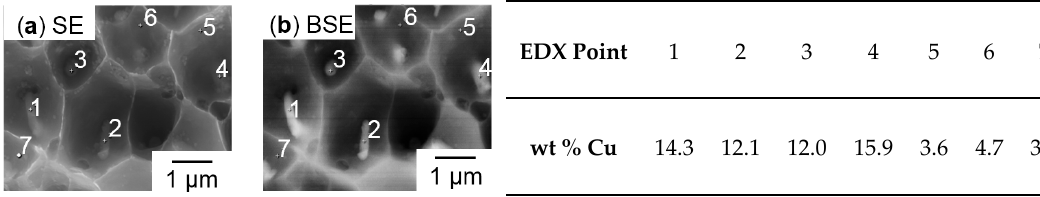
Figure 11. Non-heat-treated vertical specimen in ( a ) SE and ( b ) BSE contrast; energy dispersive X-ray spectroscopy (EDX) point measurements 1–4 showed higher Cu-contents in particles than in points 5–7 in the background.